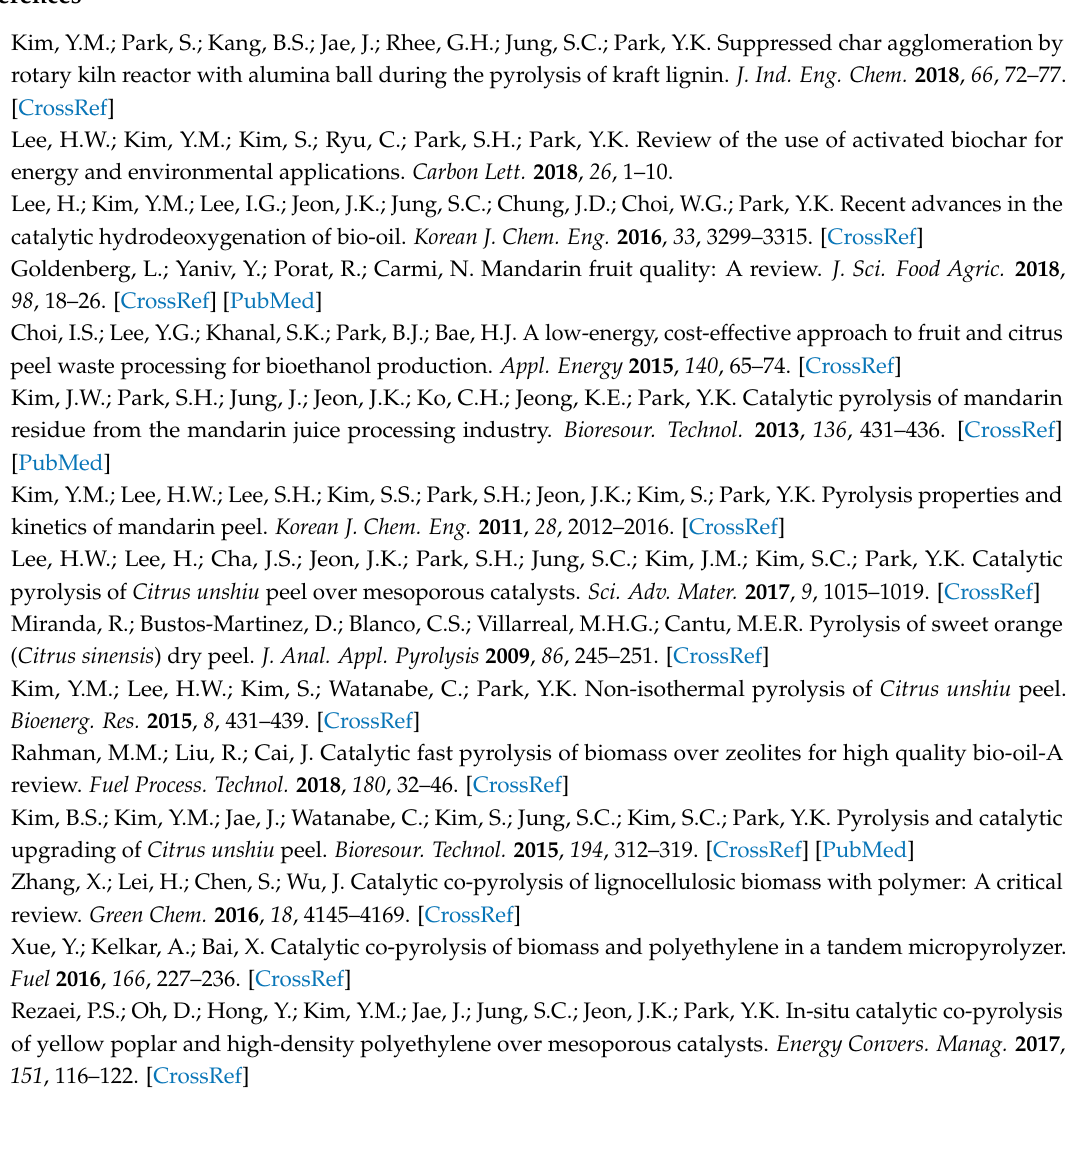
Table S1: The yields of aromatics obtained from the catalytic pyrolysis of MP, HDPE, and their mixture over HY and HZSM-5 at 600 ◦ C; Table S2: Physico-chemical properties of MP and HDPE; Figure S1: The Schematic diagram of